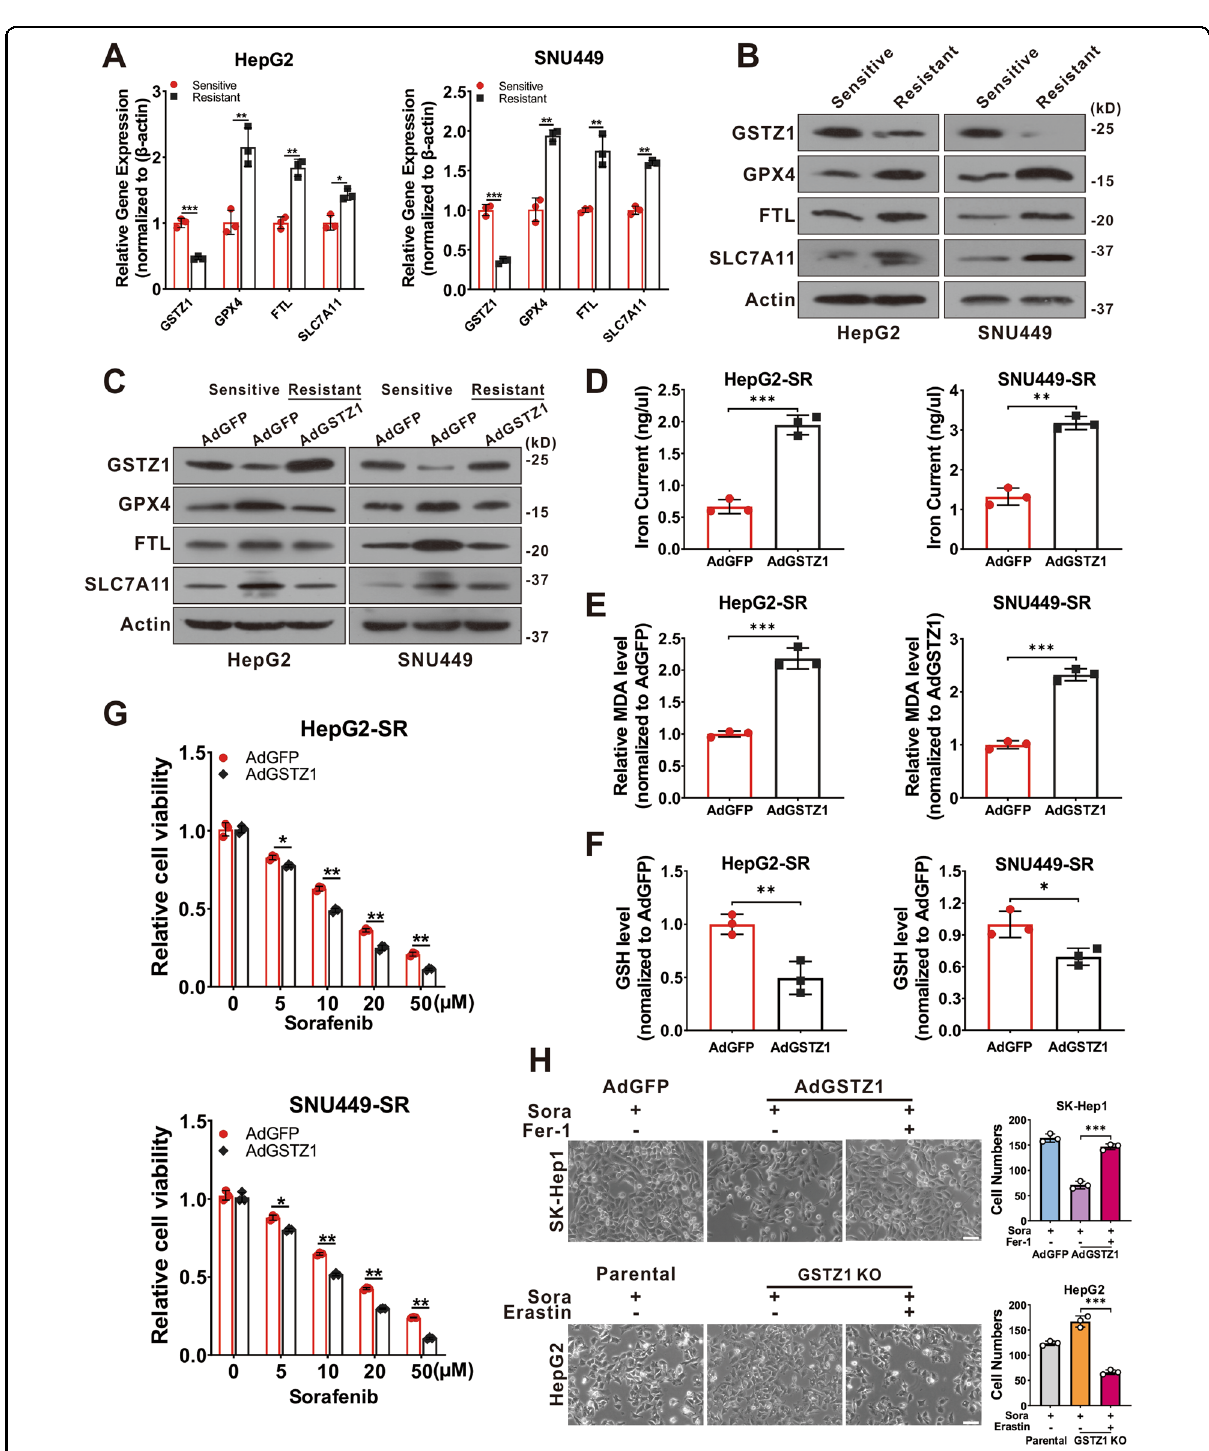
Fig. 4 GSTZ1 overexpression sensitizes hepatoma cells to sorafenib-induced ferroptosis. A , B mRNA ( A ) and protein ( B ) levels of ferroptosis- related genes in sorafenib-sensitive and -resistant cells were assayed using qRT-PCR and western blotting, respectively. C Western blotting for assessment of protein levels of ferroptosis-related genes in sorafenib-resistant HCCs with adenoviruses expressing GFP (AdGFP) or GSTZ1 (AdGSTZ1). D – F Iron ( D ), MDA ( E ) and GSH ( F ) levels in GSTZ1-OE sorafenib-resistant cells. G Cell viability was determined using CCK-8 assay. H Morphology (left) and quanti fi cation (right) of indicated HCC cells treated with sorafenib (10 μ M for 24h) alone or in combination with Fer-1 (1 μ M for 24h) or erastin (10 μ M for 24h). Scale bar = 10 μ m. For western blotting, 50 μ g protein was loaded per well. Fer-1: ferrostatin-1, SR sorafenib resistant. Values represent the mean±SD ( n = 3). The qRT-PCR data determined from three independent experiments. * p <0.05, ** p <0.01, *** p <0.001, Student ’ s t -test (two